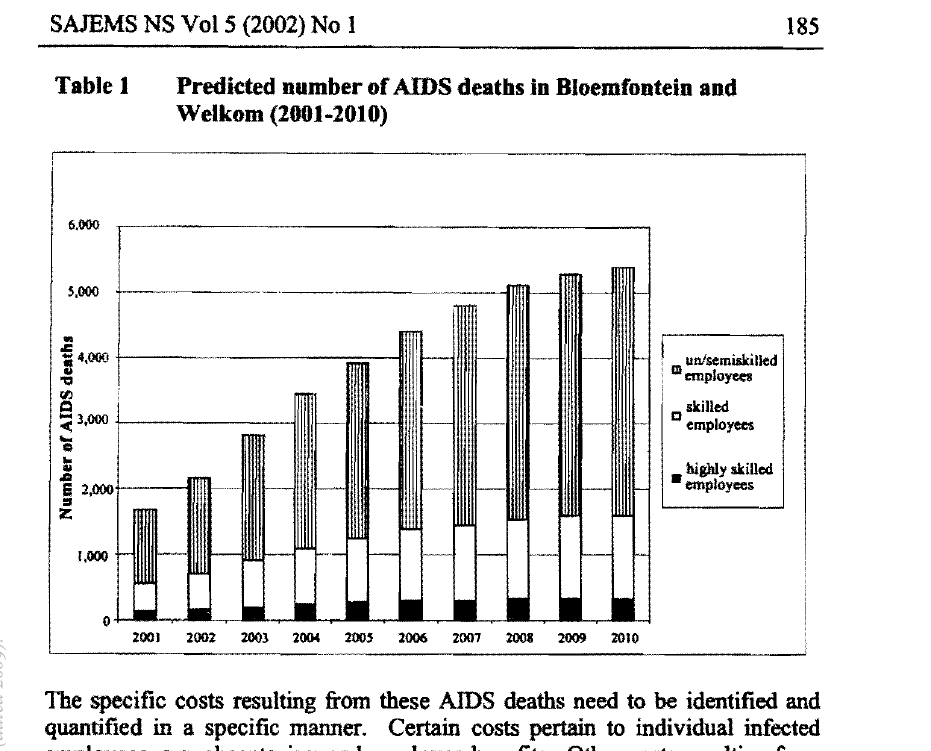
Predicted number of AIDS deaths in Bloemfontein